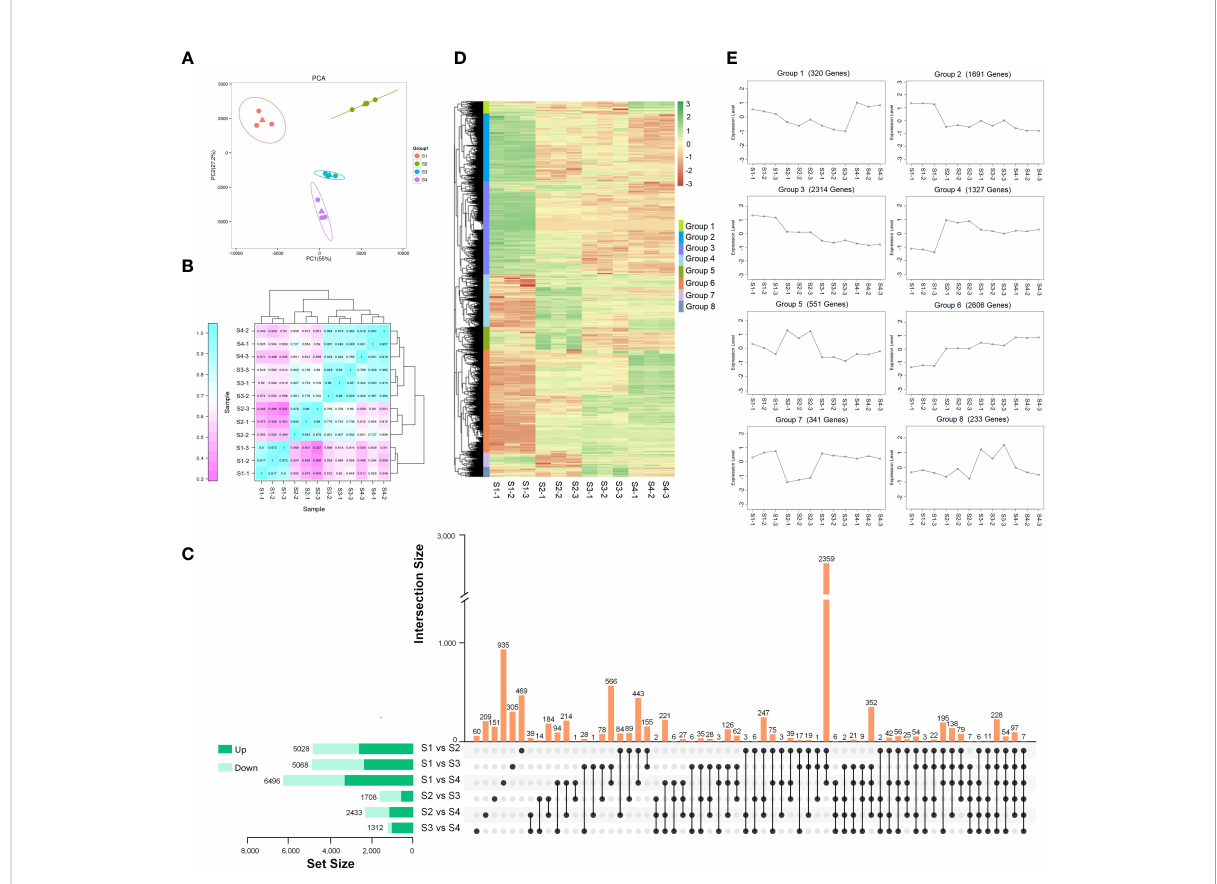
FIGURE 3 Transcriptome analysis of lettuce fl eshy stem during four expansion stages (S1, S2, S3, and S4). (A) Principal component analysis (PCA) of gene expression at four expansion stages (S1, S2, S3, and S4). (B) Pearson correlation coef fi cient of gene expression in four expansion stages (S1, S2, S3, and S4). (C) Comparisons of up-regulated DEGs (dark green) and down-regulated DEGs (light green) in the paired comparison of each expansion period. (D) Hierarchical clustering heatmap of the identi fi ed DEGs. (E) K-means clustering of the DEGs